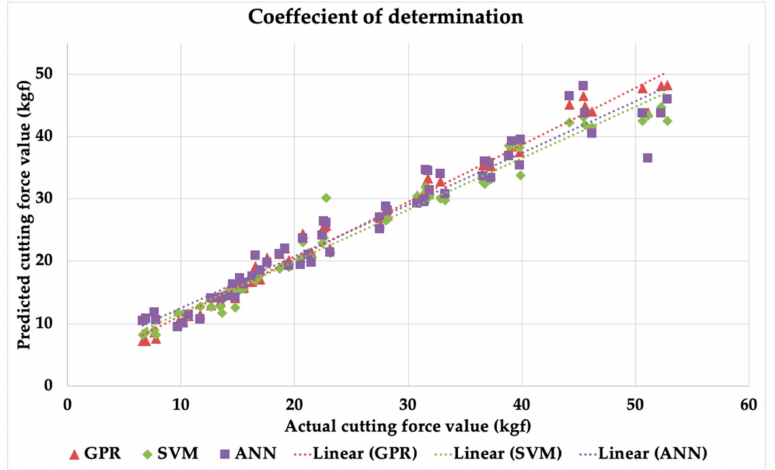
Figure 3. Actual values of the cutting force in comparison with values predicted by GPR, SVM, and ANN and coefficient of determination trend